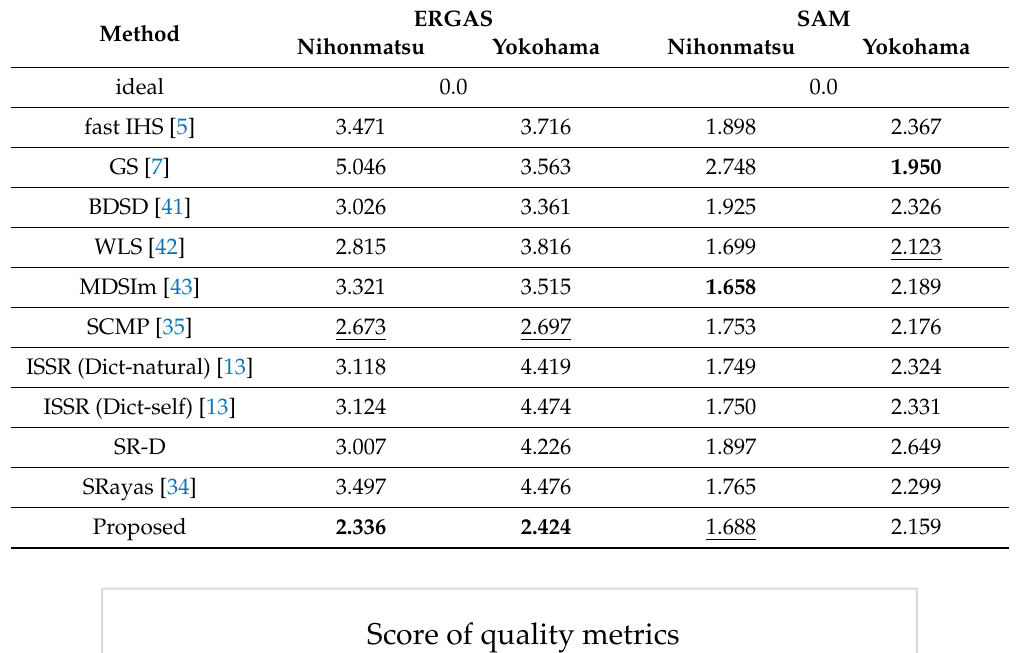
Table 8. Numerical evaluation of the existing methods and the proposed method by ERGAS and SAM. The highest scores are printed in bold, and the second highest scores are underlined.